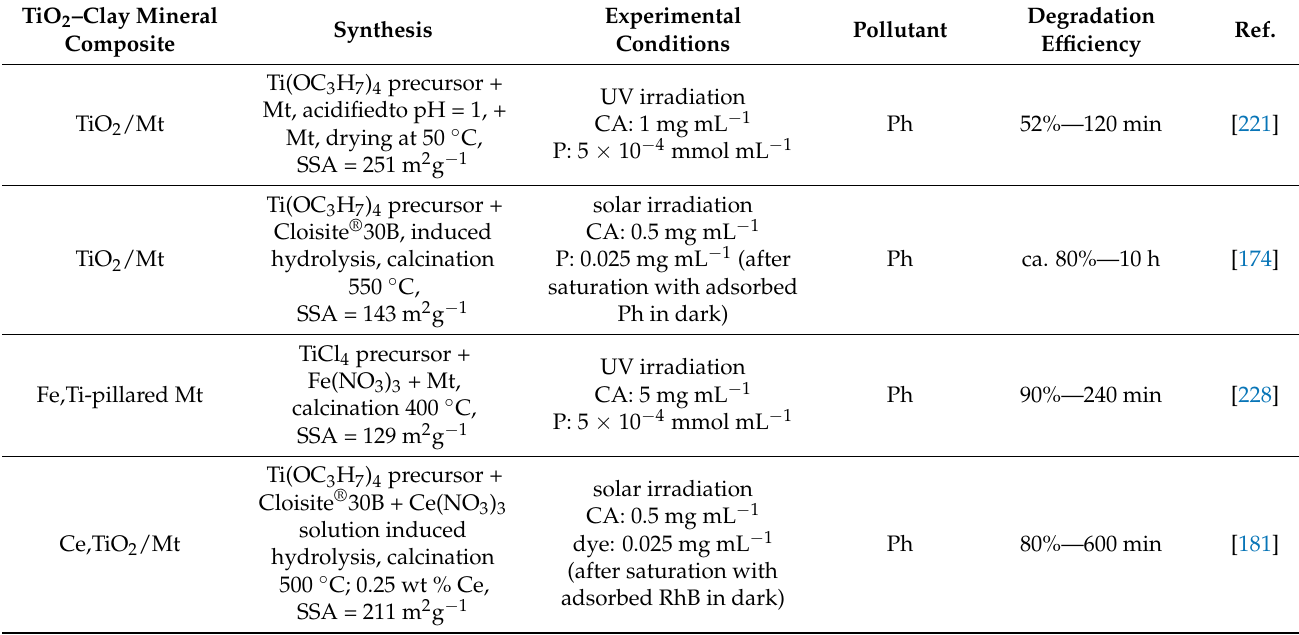
Table 6. Main synthesis and photocatalysis data for examples of TiO 2 composites with clay minerals used as photo- catalysts for the degradation of phenolic compounds (CP—chlorophenol, DCP—dichlorophenol, TCP—trichlorophenol, NP—nitrophenol, Ph—phenol, Bei—beidellite, Kao—kaolinite, Lap—Laponite, Pal—palygorskite, Sep—sepiolite, Ver— vermiculite, CTA—cetyltrimethylammonium cation, HDPM—hexadecylpyridinium cation, P—pollutant, CA—catalyst